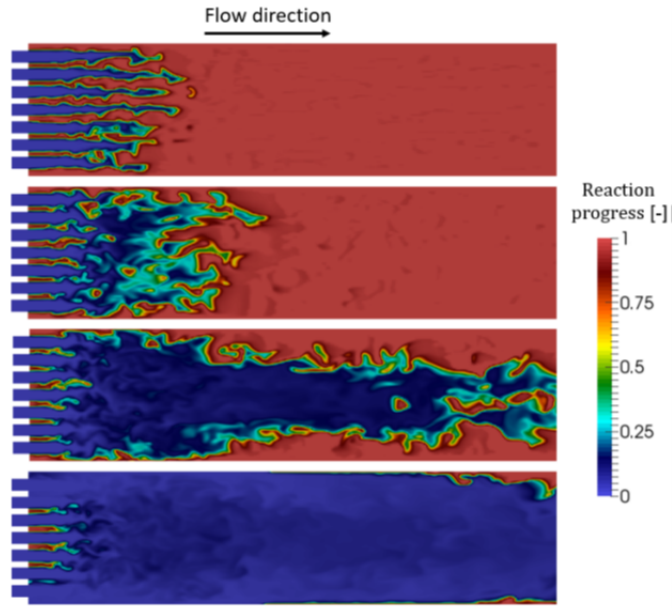
Figure 10. The simulation of flame shape elongation near LBO with increased inlet velocity and constant Φ [54].